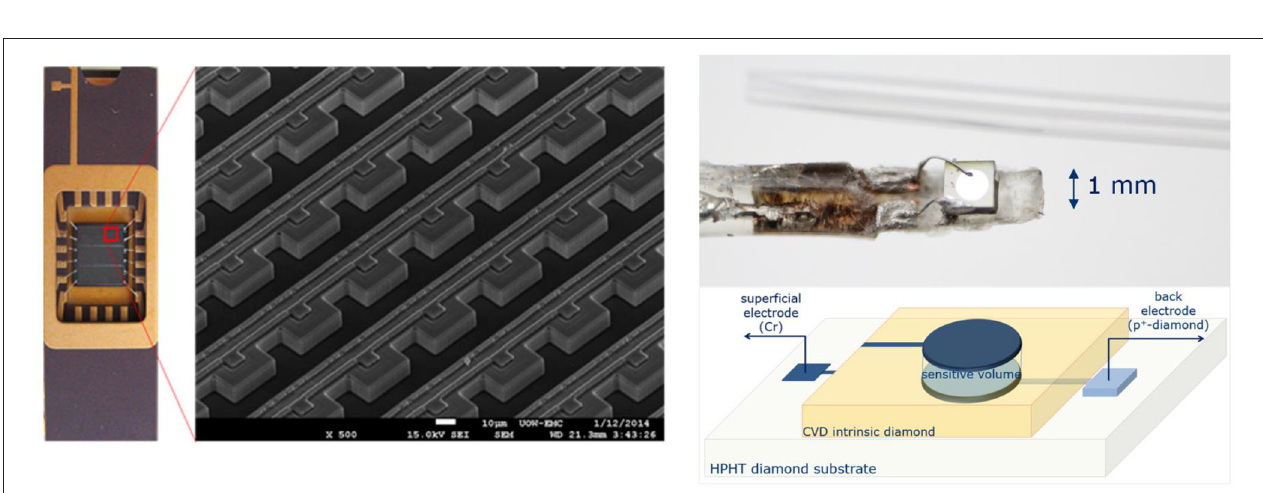
FIGURE 4 | (Left) : MicroPlus Bridge probe and electron-microscope scanning showing an array of sensitive volumes of the bridge microdosimeter. (Right) : Diamond microdosimeter and its schematic representation showing the external circular electrode defining the sensitive volume.